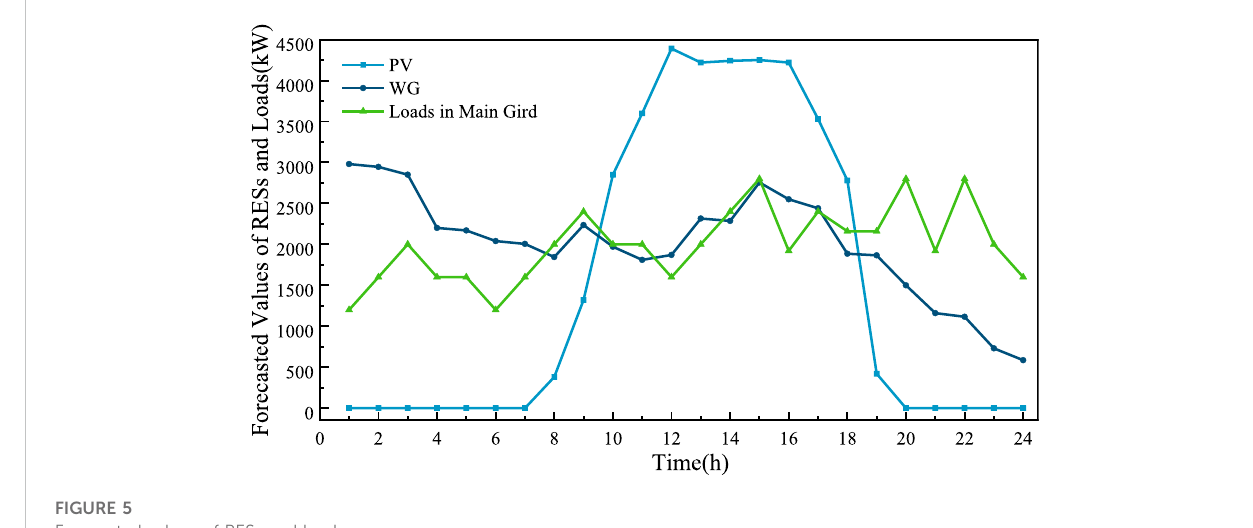
FIGURE 5 Forecasted values of RESs and loads.